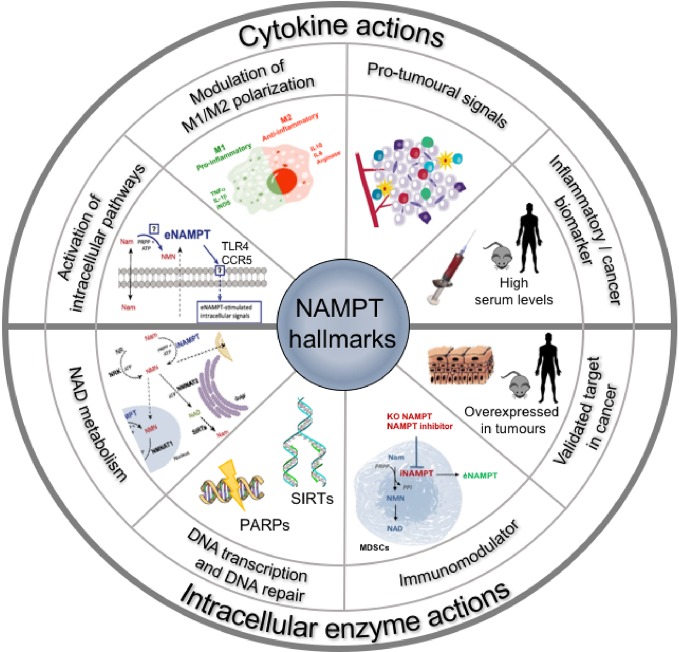
Hallmarks of NAMPT: the roles of the extracellular and intracellular forms of NAMPT.